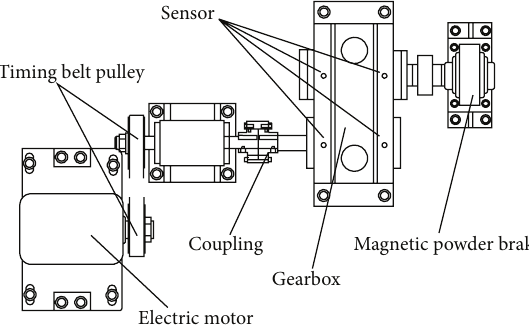
Figure 2: Experimental